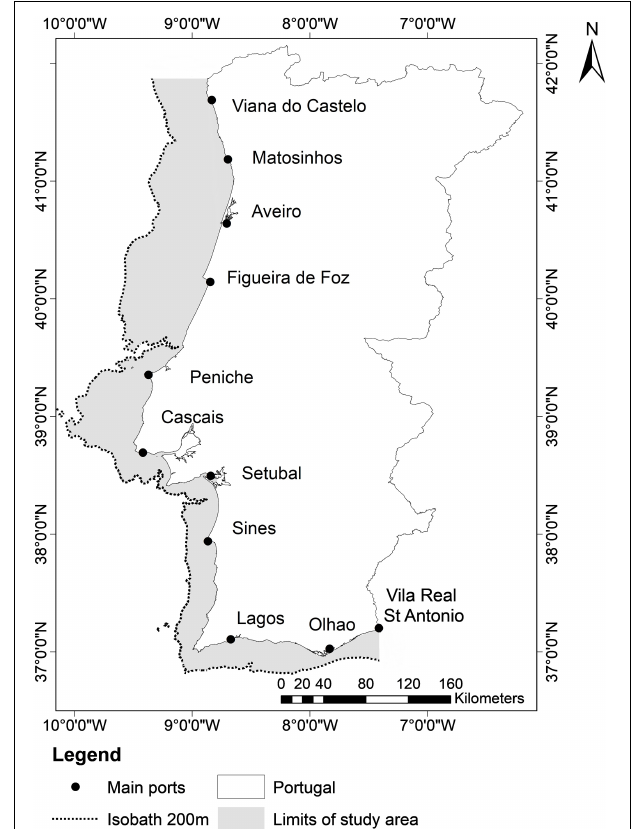
FIGURE 1 | Map showing limits of the study area (200 m